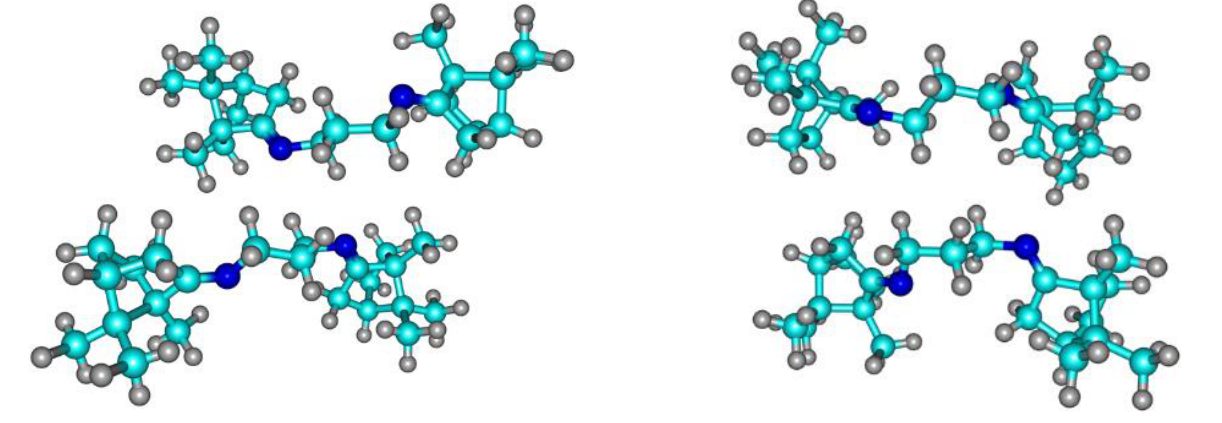
Figure 3. Structure of CPDA dimers in the tg conformational state.